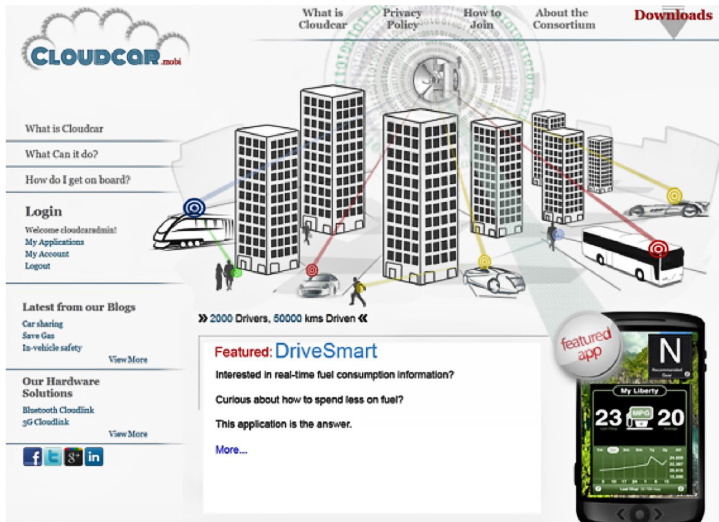
Fig. 6. Screenshot of the prototype CloudThink store for registration and application